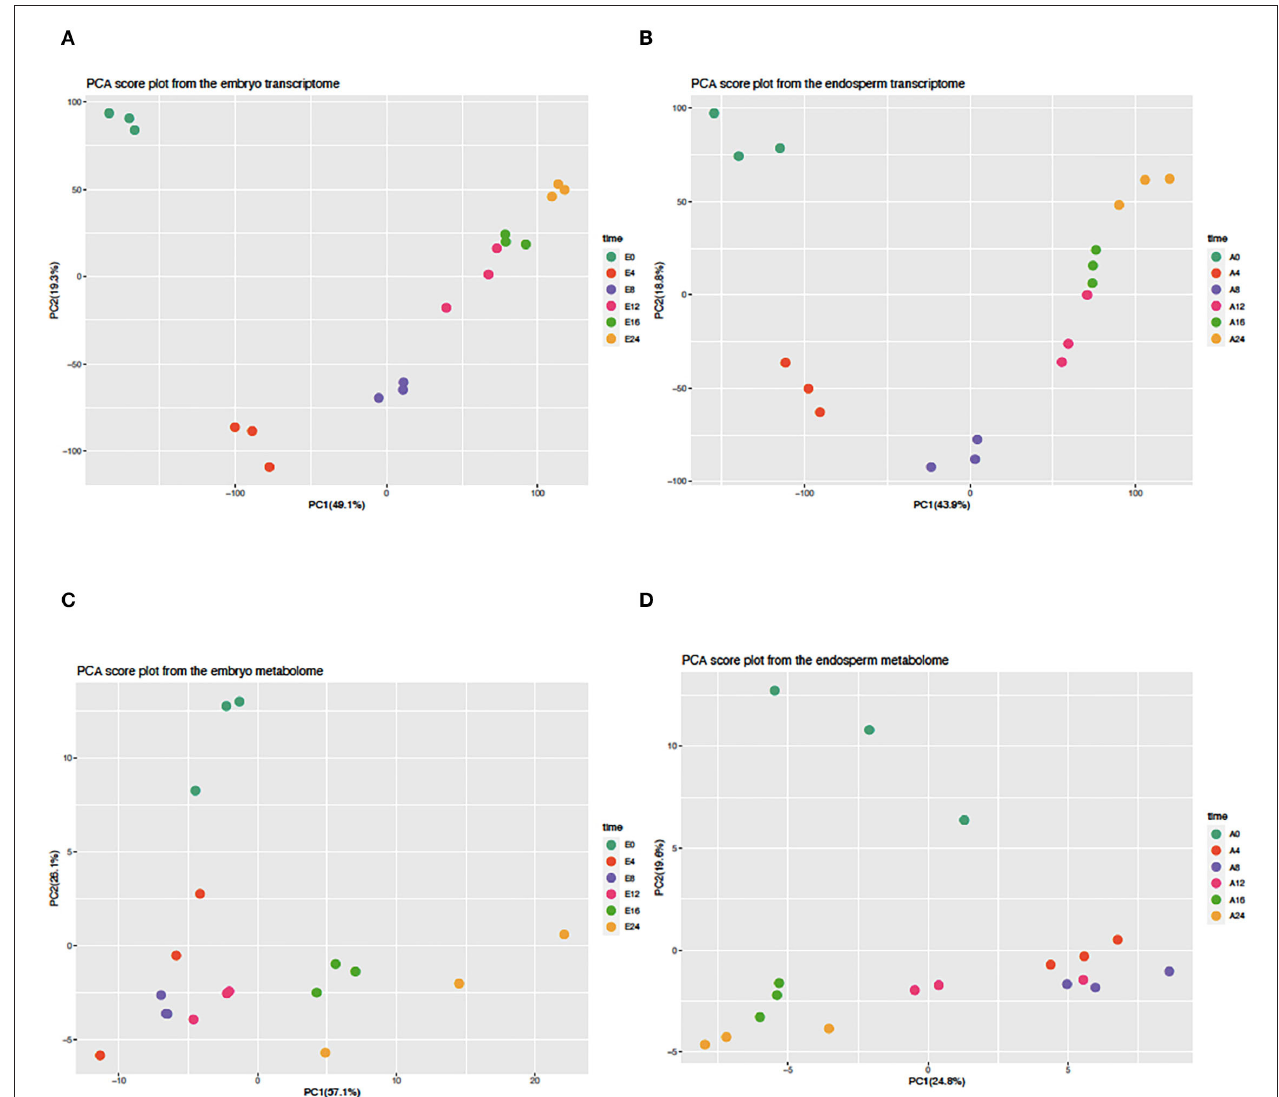
FIGURE 2 | Principal component analysis of embryo and endosperm transcriptomes and metabolomes. The normalized transcript (A,B) and metabolite (C,D) abundance of isolated embryos (A,C) and endosperms (C,D) were subjected to a principal component analysis (PCA) of which the first two components are shown in each graph. The percentage of explained variance is indicated along each axis. All values were centered and scaled before computing the